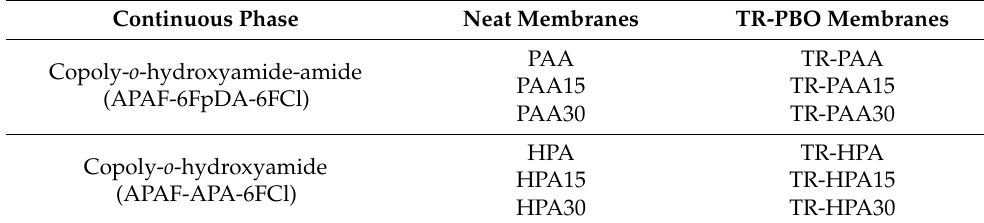
PAA TR-PAA PAA15 TR-PAA15 PAA30 TR-PAA30 HPA TR-HPA HPA15 TR-HPA15 HPA30